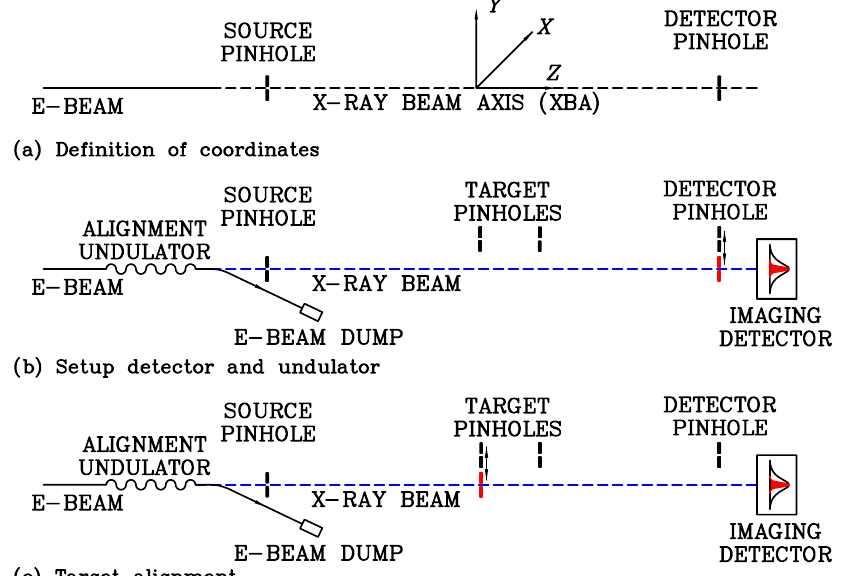
FIG. 1. (Color) Schematics showing the alignment procedure: (a) Definition of the XBA coordinate system, (b) setup of the XBA, and (c) alignment of target